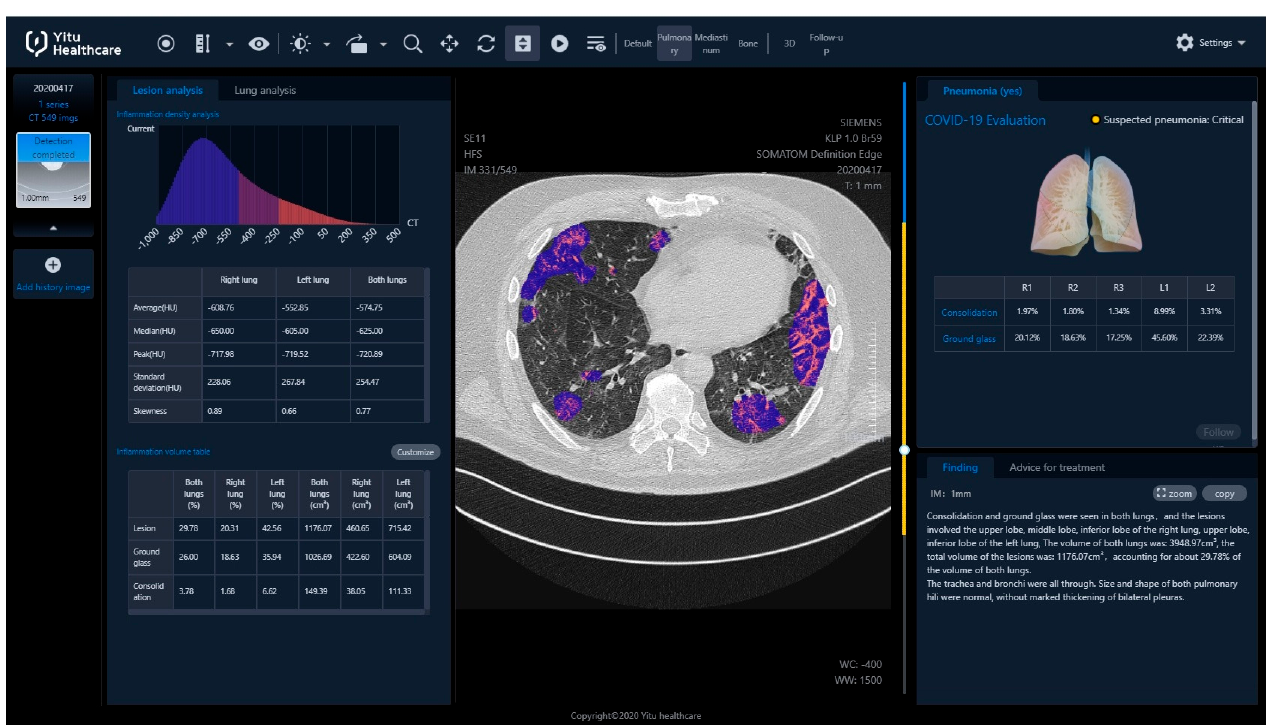
Figure 2. The final report from automatic assessment of HRCT images by the software, using artificial intelligence tech- nology.